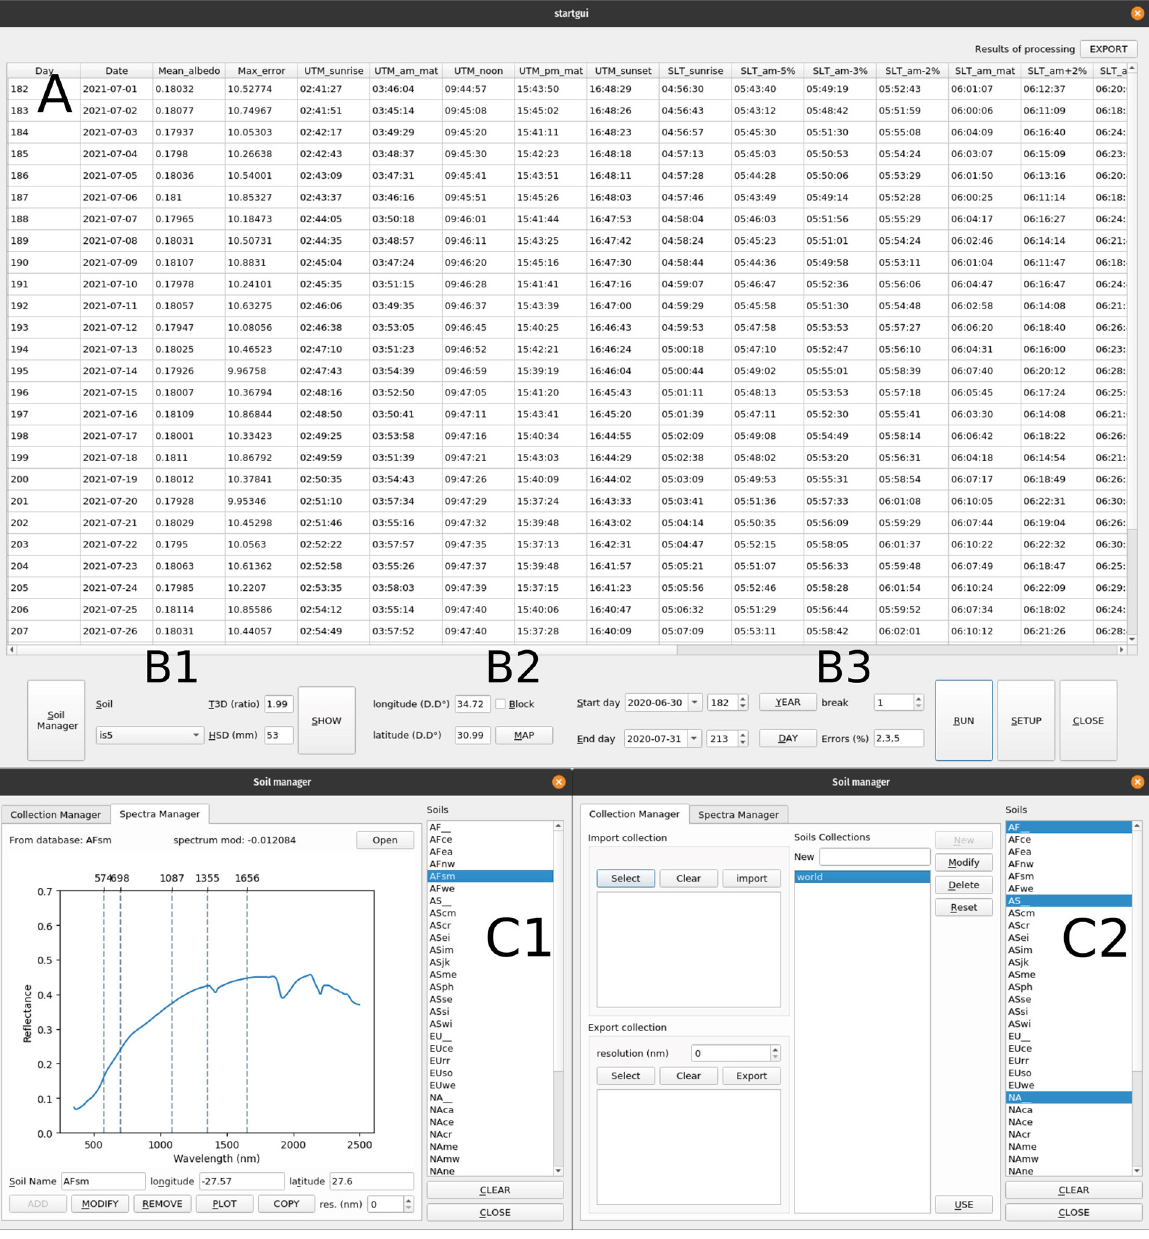
Fig. 6. GUI of SALBEC: (A) main window – results of the calculations; (B1) ribbon – soil section; (B2) geo- location; (B3) days of the analysis; (C1) spectra manager and (C2) collection manager. GUI, graphic user interface; SALBEC, Soil ALBEdo